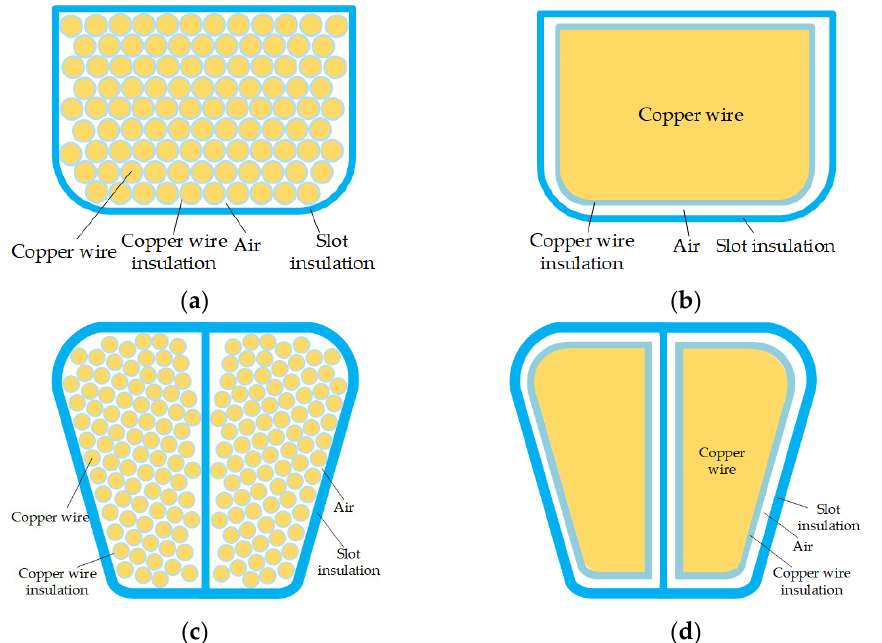
Figure 8. Equivalent diagram of winding in DHEG slot: ( a ) Actual winding distribution diagram of excitation winding; ( b ) Equivalent winding distribution diagram of excitation winding; ( c ) Actual winding distribution diagram of armature winding; ( d ) Equivalent winding distribution diagram of armature winding.